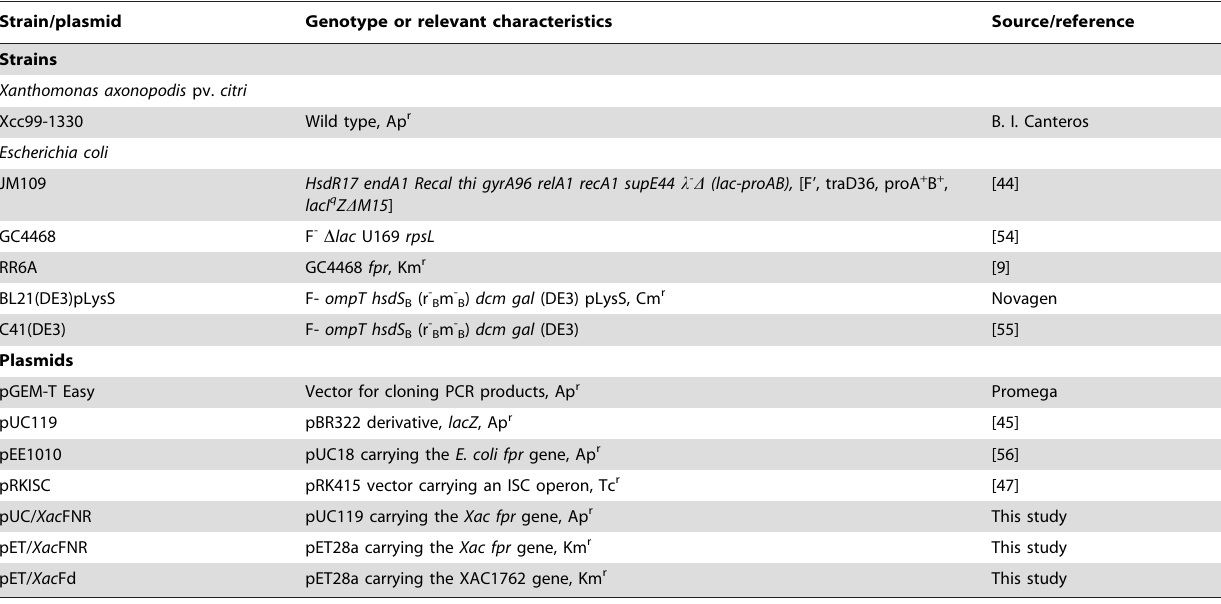
Table 3. Bacterial strains and plasmids used in this